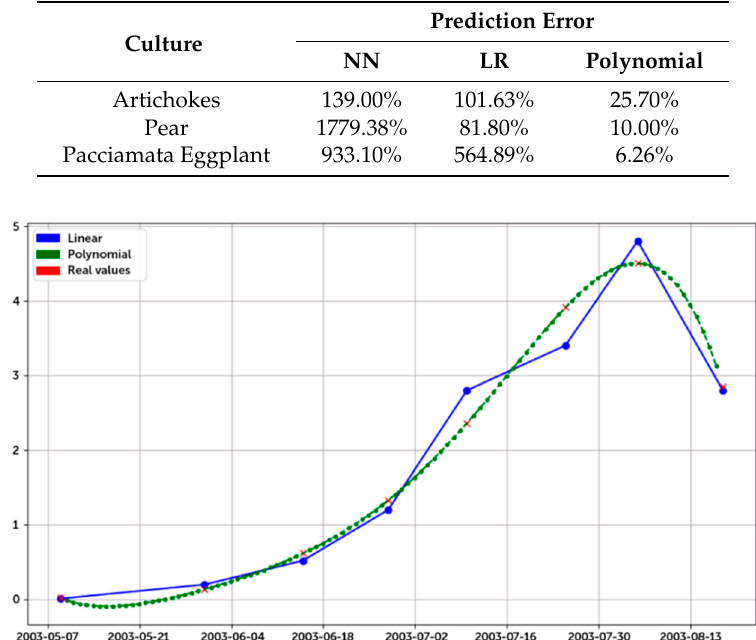
Figure 7. Task 2: plot comparison between real-values (red dots), the linear (blue), and polynomial (green) predictive model on the CNR scientific agrarian dataset.